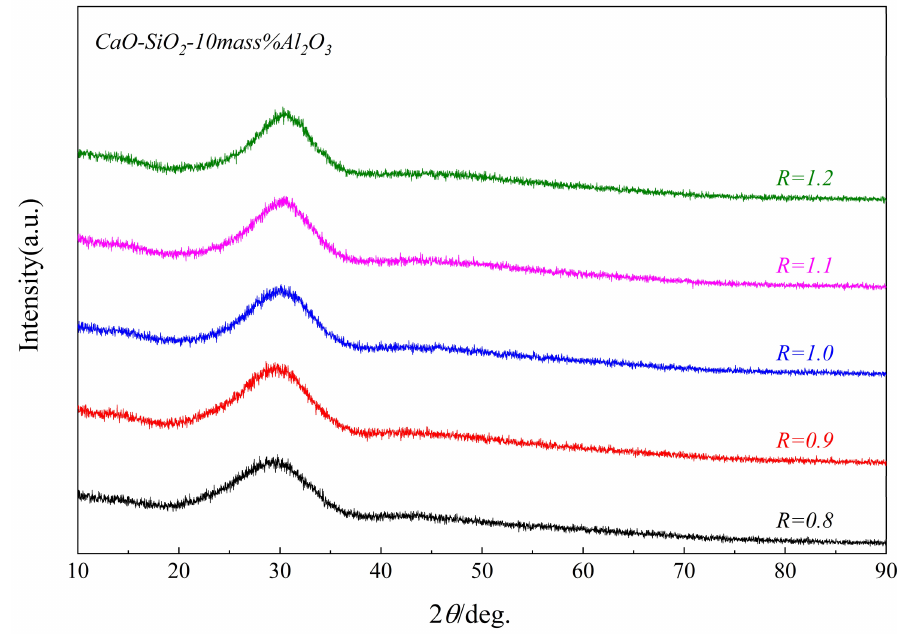
Figure 3. XRD patterns of samples with different R glass phases.